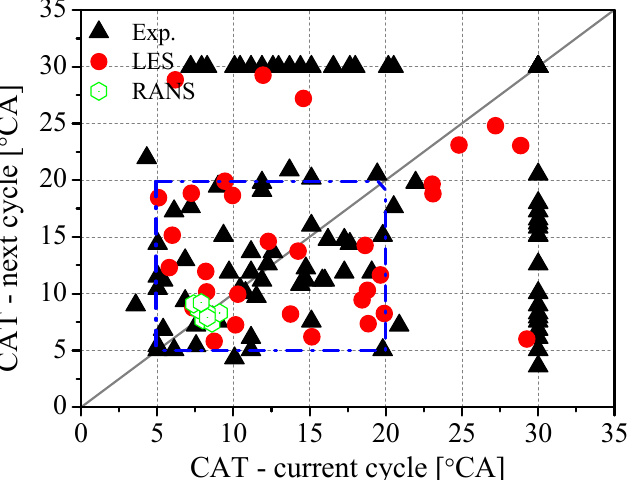
Figure 8. Distribution of CATs for the current cycle and next cycle in experiments, LES and RANS simulations.